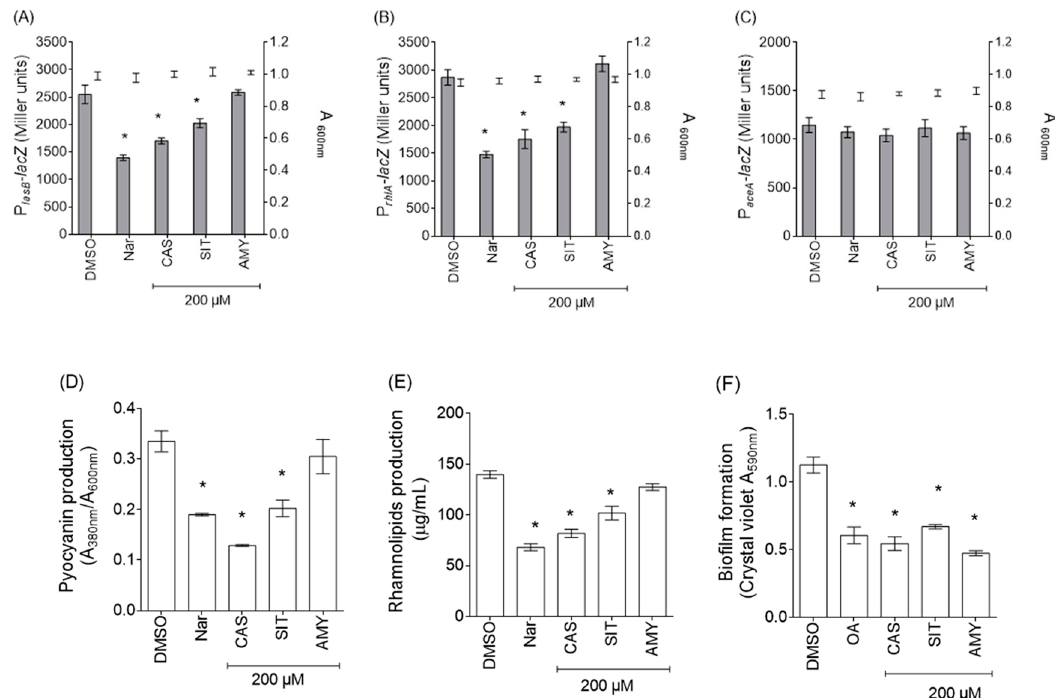
Figure 3. Anti-virulence effects of isolated compounds from P. rotundifolium EtOAc extracts in P . aeruginosa PAO1: ( A ) effect of isolated compounds on the expression of QS-regulated lasB gene; ( B ) effect of isolated compounds on the expression of QS-regulated rhlA gene; ( C ) effect of isolated compounds on the expression of QS-independent aceA gene; ( D ) effect of isolated compounds in biofilm formation; ( E ) effect of isolated compounds on pyocyanin production; and ( F ) effect of isolated compounds on rhamnolipids production. Each isolated compound was tested at 200 µM; naringenin (Nar, 4 mM) is used as a reference QS inhibitor; oleanolic acid (OA, 800 µM) is used as an anti-biofilm control and dimethylsulfoxide (DMSO, 1%) as a solvent control. The cell density of the bacteria was assessed at 600 nm (bold error bars) and gene expression was measured as the β -galactosidase activity of the lacZ gene fusions and expressed in Miller units (grey bar). Biofilm formation was quantified by crystal violet staining and measured at A 590nm . Pyocyanin was extracted, quantified by absorbance measurements at 380 nm and calculated as the ratio between A 380nm and A 600nm . The rhamnolipids production was measured using methylene-blue-based method and expressed in µg/mL. Error bars represent the standard errors of the means; all experiments were performed in quintuplicate with three independent assays and asterisks indicate samples that are significantly different from the DMSO (One-way ANOVA followed by Dunnett’s test of multiple comparisons; p < 0.01). AMY: α -amyrin; CAS: cassipourol; and SIT: β -sitosterol.